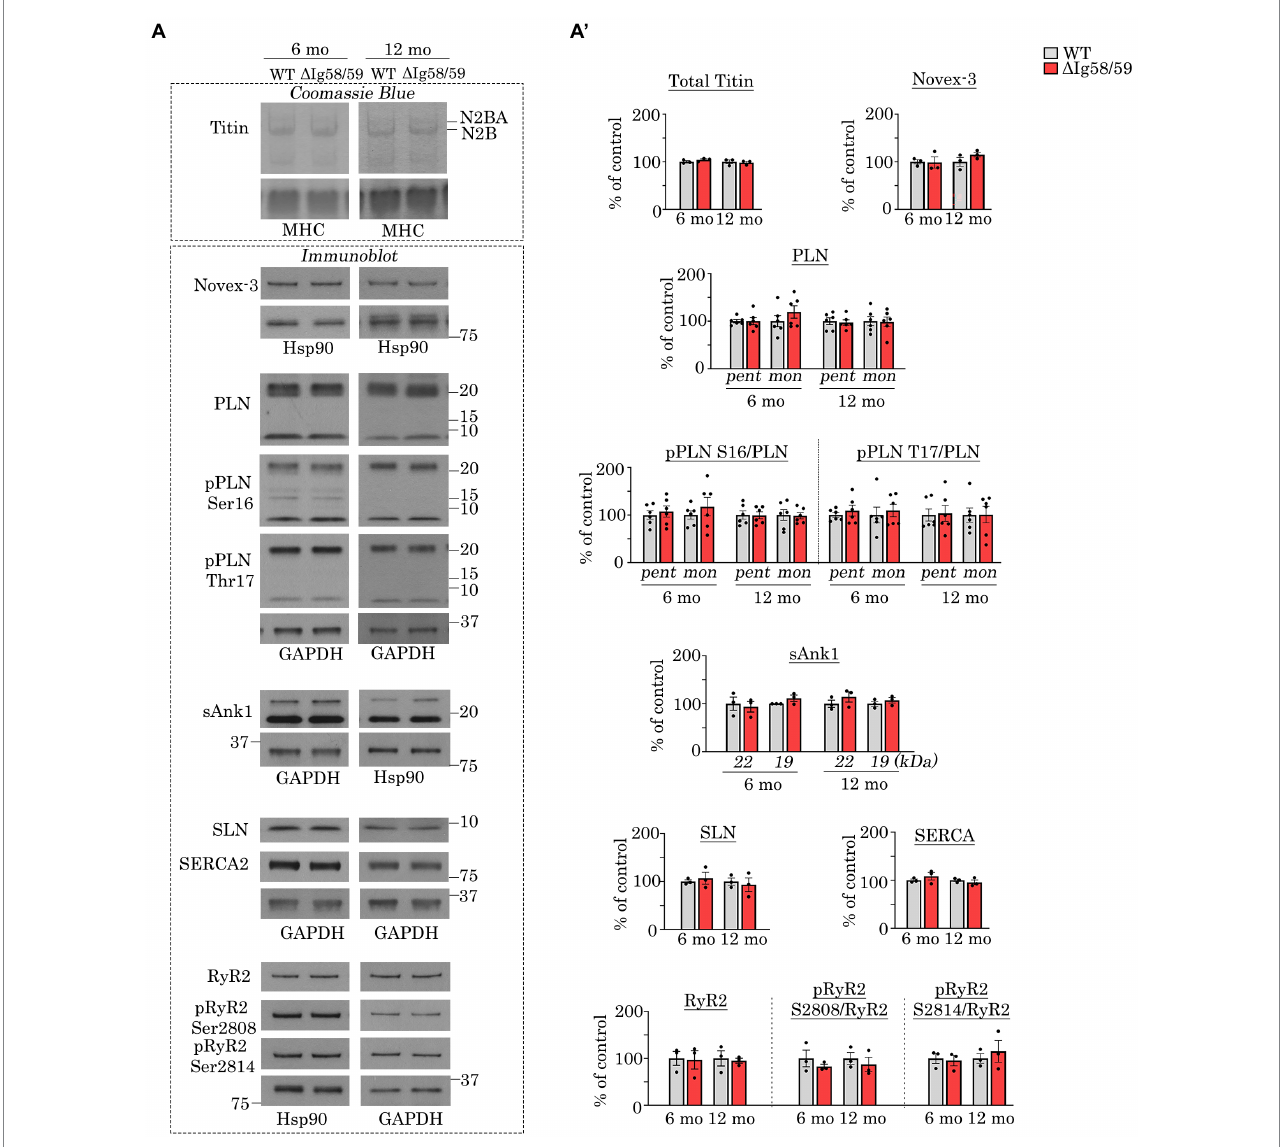
FIGURE 2 Expression and phosphorylation status of Ig58/59 binding partners and selected Ca 2+ cycling proteins are unaffected in aged Obscn- Δ Ig58/59 atria. (A,A’) Representative Coomassie Blue stained agarose gels and immunoblots (A) and relative quantifications (A’) did not reveal statistically significant alterations in the expression or phosphorylation status of giant titins, novex-3, PLN, sAnk1, SLN, SERCA2, or RyR2 in lysates prepared from 6- and 12-month-old Obscn- Δ Ig5859 atria; MHC, Hsp90, and GAPDH served as loading controls; n = 3–6 animals per group; data points represent the average of at least two technical replicas; quantification of phosphorylation levels are normalized to total PLN or RyR2 levels; pent, pentamer; mono,